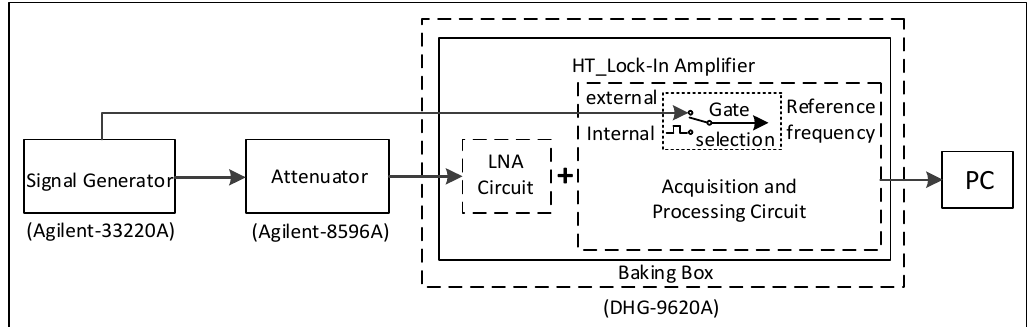
Figure 12. Schematic of the high-temperature digital lock-in amplifier test setup. The reference frequency of the digital lock-in amplifier was provided by an internal or external reference depending on the working method. The external reference provided by the signal generator (consistent with the frequency of the output signal) was used in the test process. The internal reference was controlled by the MCU, which could generate a clock signal with the requested frequency to act as the internal reference.